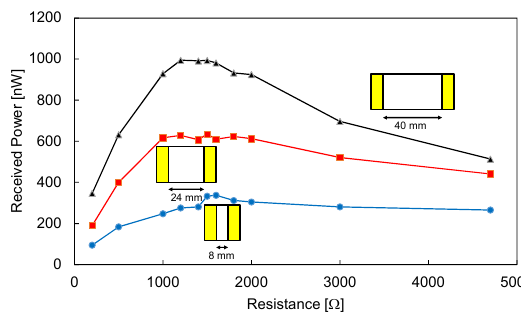
Figure 9. Relationship between input resistance and received power.